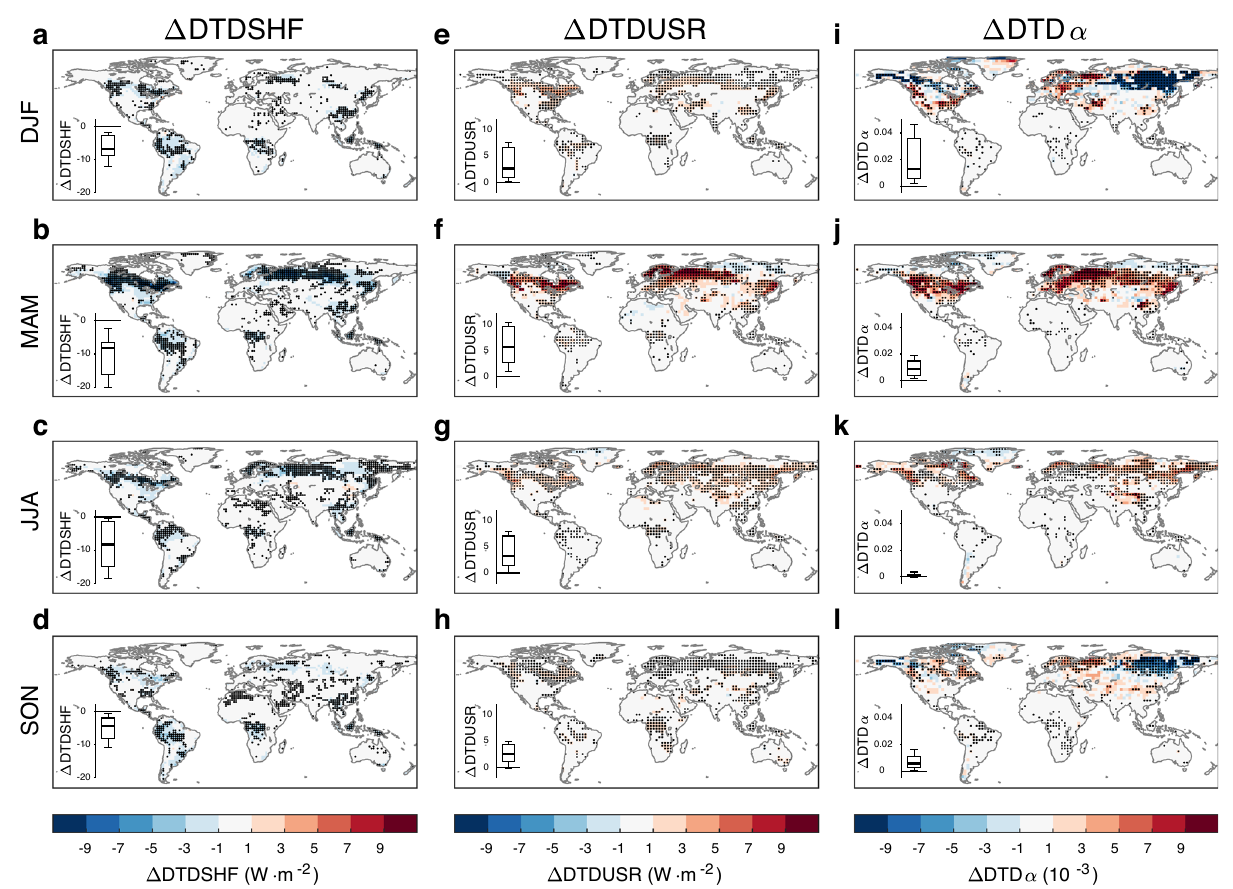
Δ DTDSHF. Δ DTDUSRand Δ DTD α arefromtheCanESM5model,andtheblackdots in e – l indicate that Δ DTDUSR or Δ DTD α is statistically signi fi cant at the 95% con- fi denceleveltestedbyStudent ’ s t -test.Thebox-and-whiskerplotembeddedineach panelshowsthecorrespondingdifferencebetweenthepairedforestandopenland sites (openland minus forest; Supplementary Fig. 5) from the FLUXNET and AmeriFlux datasets. The horizontal black line of the box denotes the median. The bottom and top edges of the box denote the 25th and 75th percentiles, respec- tively. The whiskers extend to the 10th and 90th